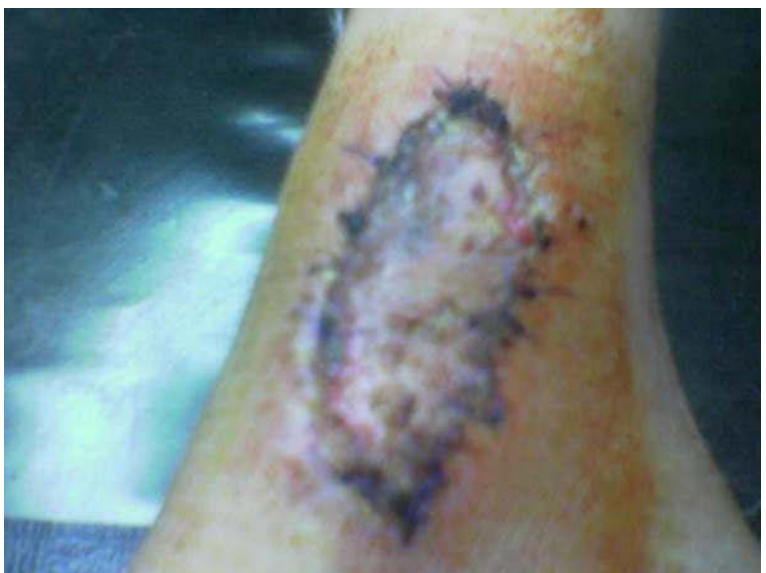
Figure 5. The operation after (10 days) the skin grafting.